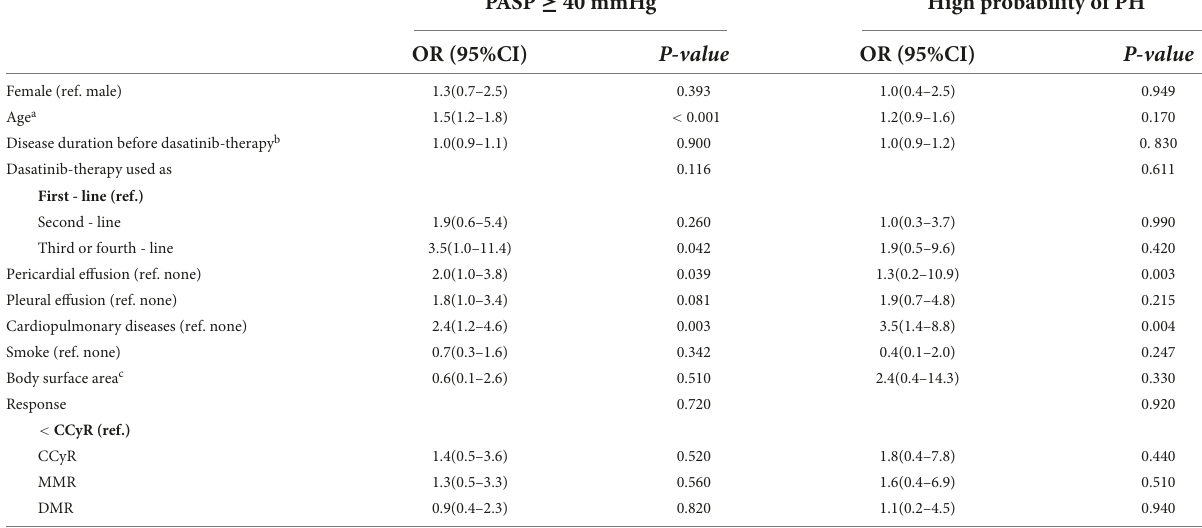
TABLE 4 Univariable analysis of associated variables in longitudinal cohort.